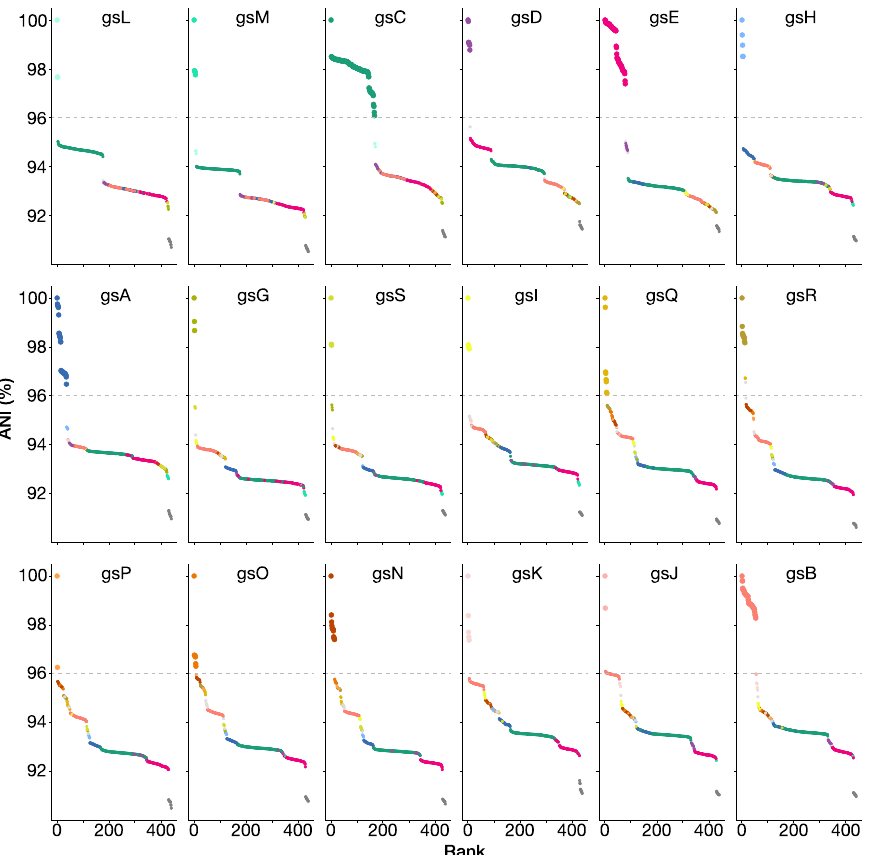
Figure 5. ANI plots using the representative strains of each of the 18 genospecies as reference. Points are colored by genospecies. Strains that are conspecific with the reference are shown with larger symbols. Dashed line at 96% ANI indicates conventional species boundary.